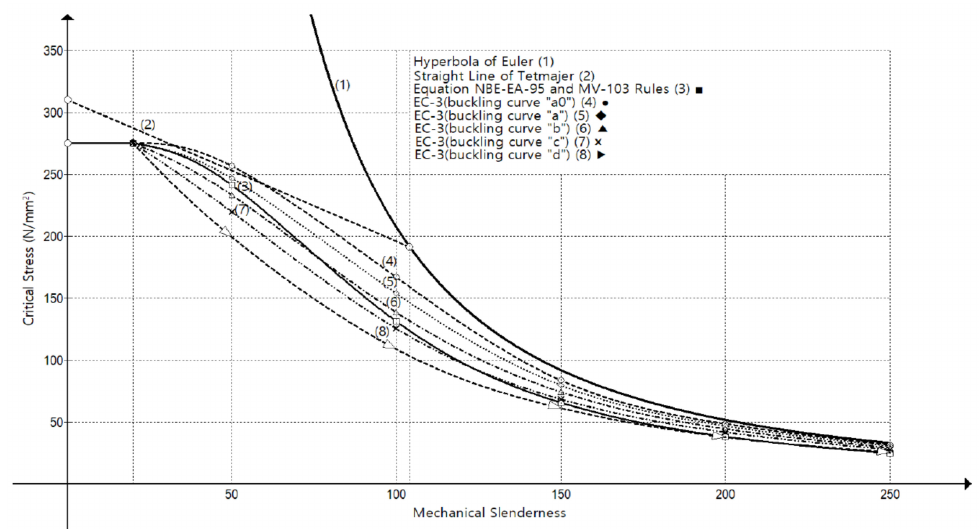
Figure 3. Strength–mechanical slenderness ratio diagram. Comparing different models from Spanish buckling standards for slender steel columns.